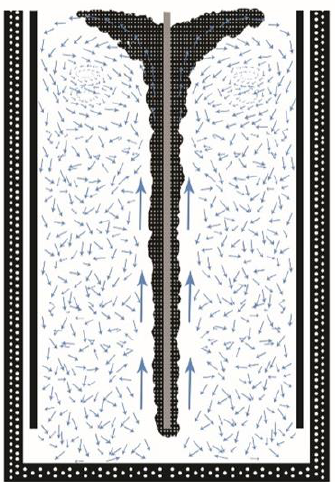
Figure 1. Hydrodynamic flows in a coaxial electrolyzer. This allows the products of the cathodic reaction (OH − ions, radicals, etc.) to reach the anode surface in a short time that prevents the aggregation of the formed particles. The process of alkalization in the electrolyzer takes less than a